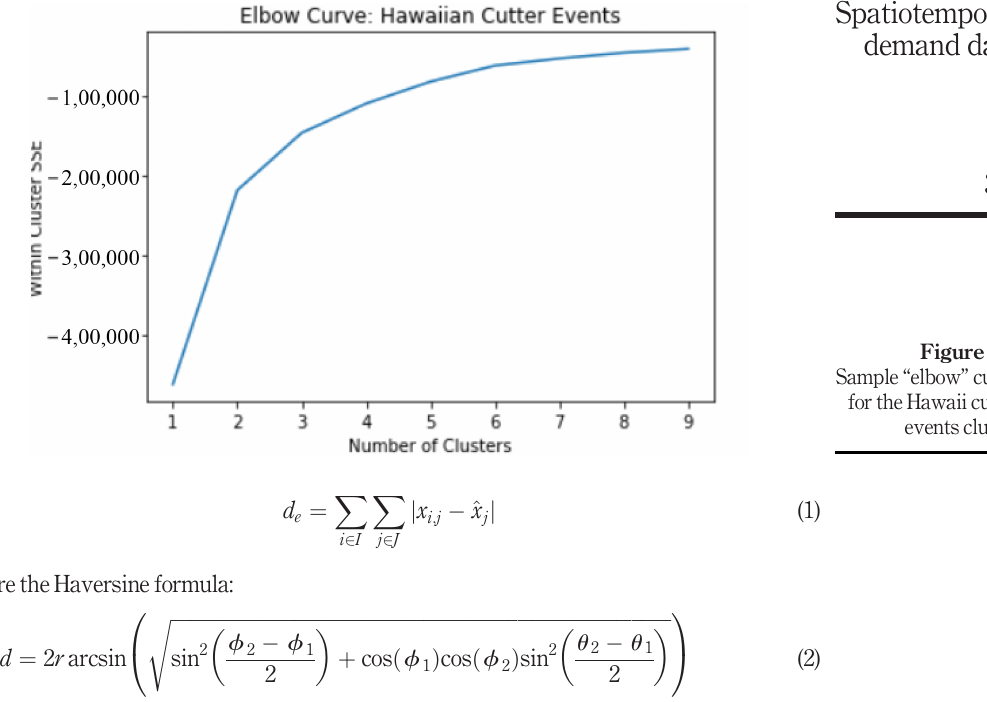
Figure 11. Sample “ elbow ” curve for the Hawaii